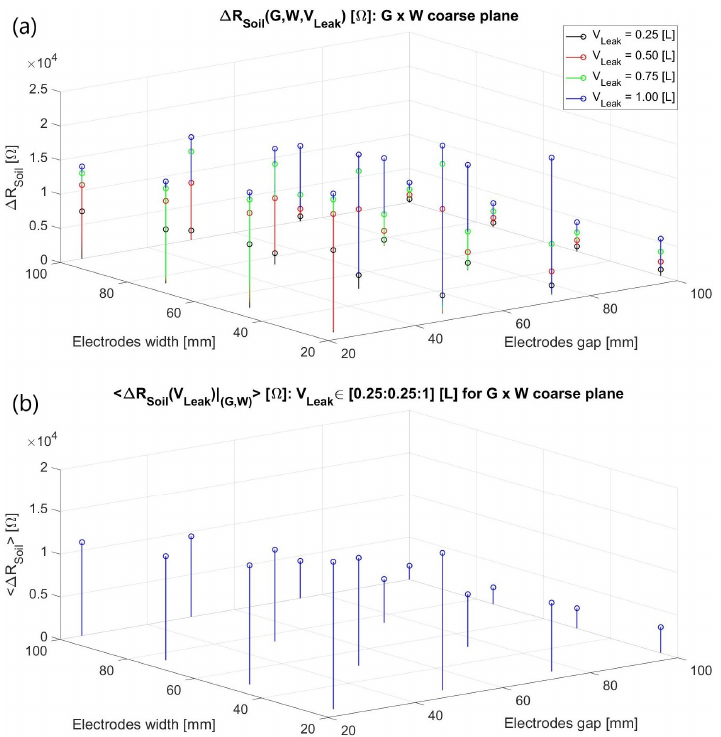
Figure 4. ( a ) Three-dimensional discrete function ∆ R Soil (G, W, V Leak ): R 3 → R elucidating the ∆ |Z ω )| dependence on the metal strips’ gap and width and the water loss volume at 1 kHz for Soil (j an arid-to-moist terrain with a nearly resistive behavior; ( b ) The preceding results were averaged for the investigated V Leak volumes at each (G, W) to circumvent potentially misleading